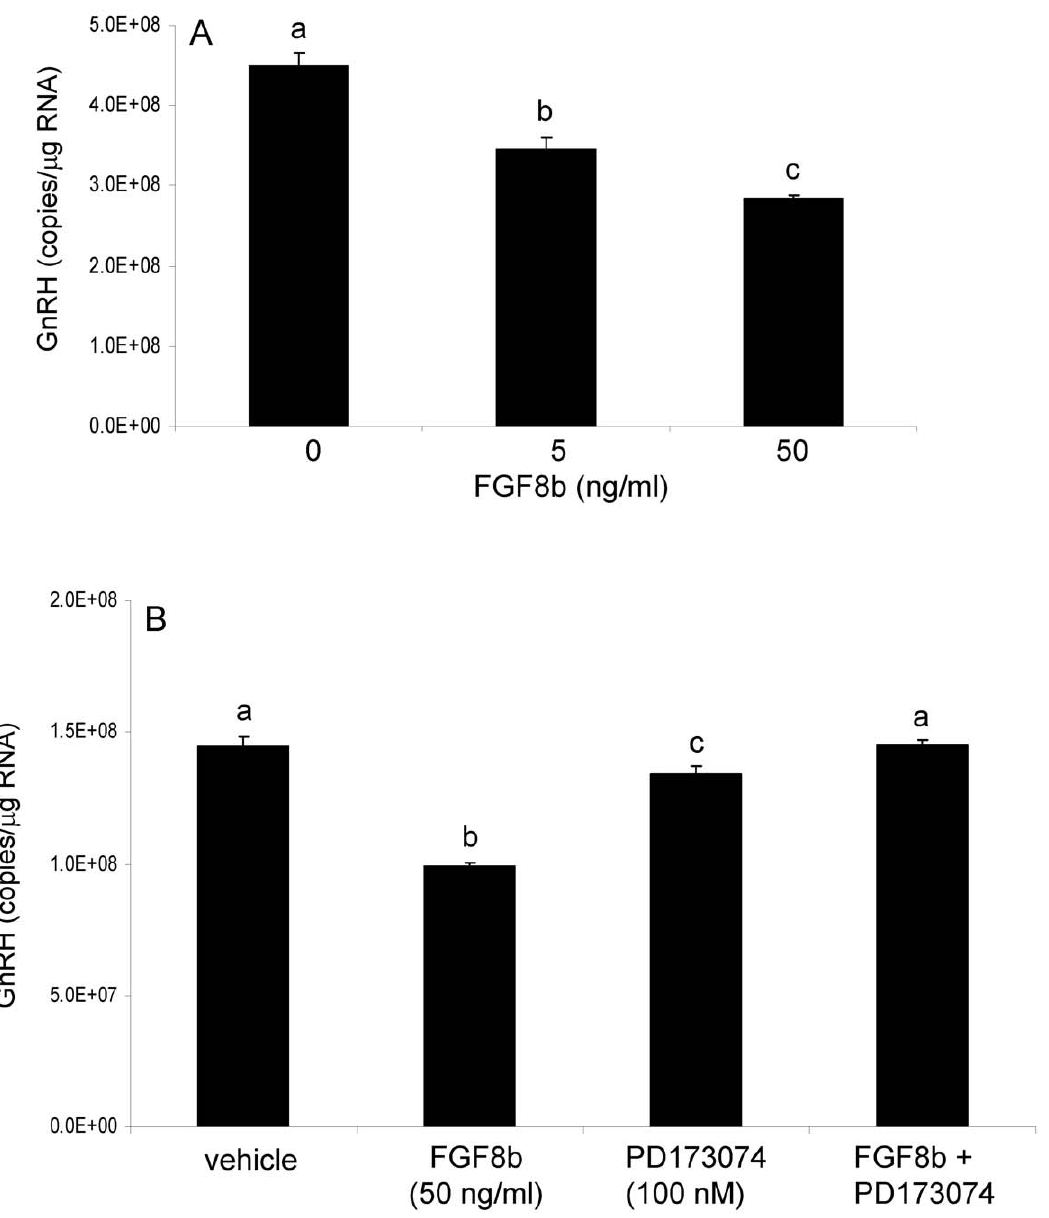
Figure 4. FGF8b decreased GnRH mRNA in GT1-7 cells. Panel A: GnRH mRNA levels in GT1-7 cells following 8 hours of vehicle or FGF8b treatment at 5 or 50 ng/ml. Panel B: GnRH mRNA levels in GT1-7 cells following treatment with vehicle, FGF8b (50 ng/ml), PD173074 (100 nM), or FGF8b + PD173074 for 8 hours. Data are expressed as mean copies of GnRH transcript/ m g total RNA 6 SEM. Dissimilar letters indicate statistically significant difference among groups, P , 0.05.